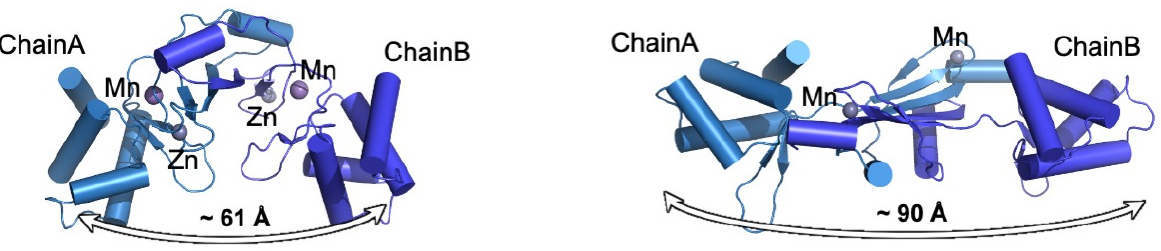
Figure 6. Reorganization of the overall dimeric assembly of B. subtilis PerR upon oxidation. PerR-Zn-Mn (left, PDB ID: 3F8N) adopts a curved conformation, and PerR-Zn-apo (right, PDB ID: 2FE3) adopts a relatively flattened structure. The oxidation of His37 to 2-oxo-histidine leads to the dissociation of His37 from the regulatory metal, preventing PerR from adopting a DNA-binding compatible curved shape. The distance denotes the distance between the two DBDs in the PerR homodimer (measured as the distance between Asn53/Asn53 ′ C α atoms).